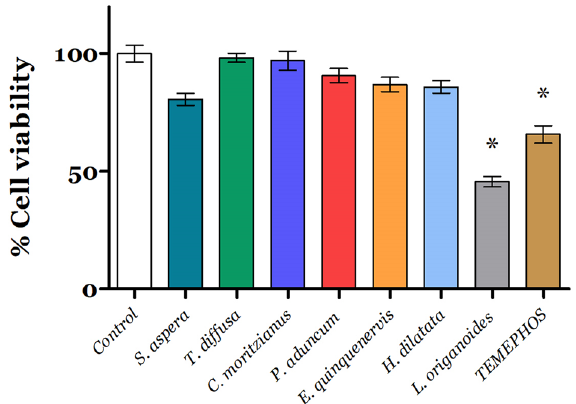
Figure 4. Cytotoxic effect of essential oils on Vero cells. Each value represents the mean ± SD of three independent experiments. *Significant statistical differences to the control p < 0.05; temephos was used as a positive